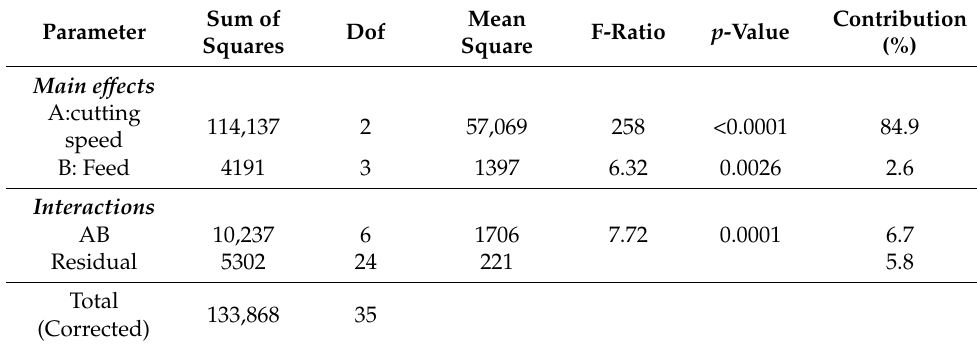
Table 6. ANOVA results for cutting temperature. Dof: degree of freedom.